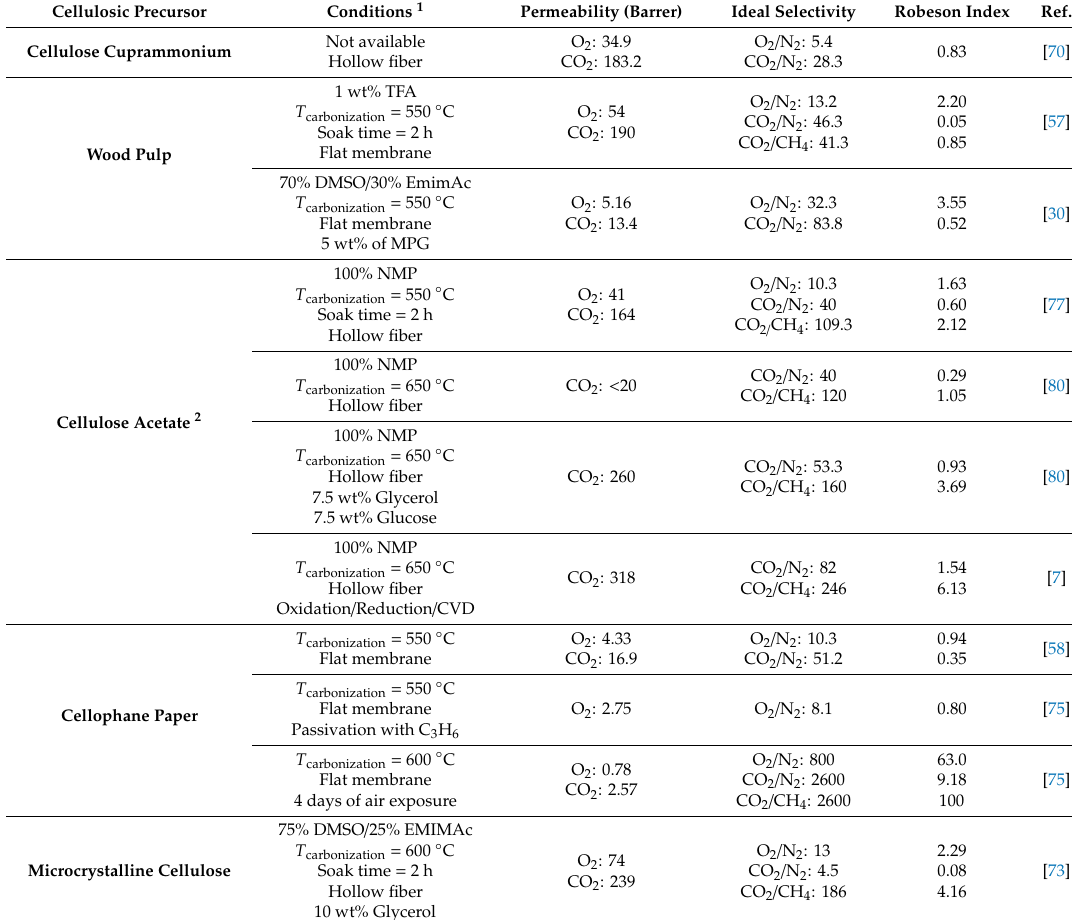
Table 3. Gas separation results of di ff erent cellulosic precursor based